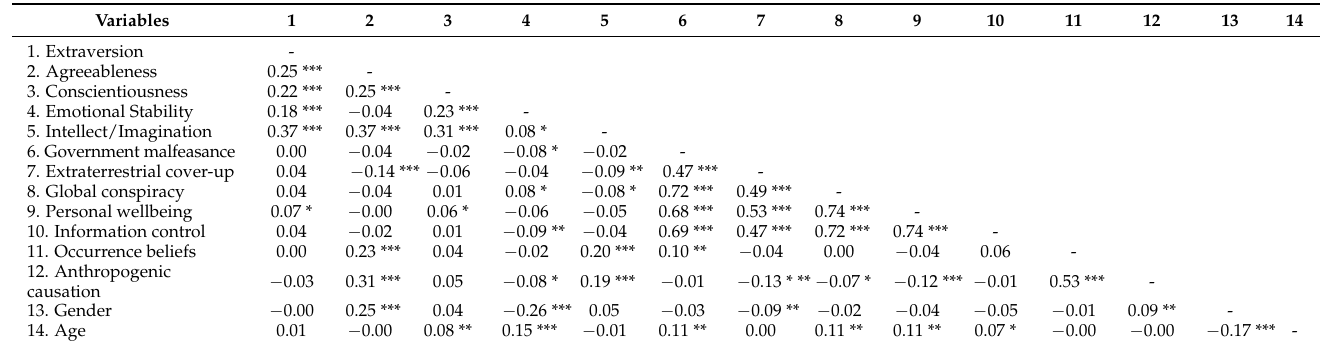
Table 2. Inter-correlations between study variables.